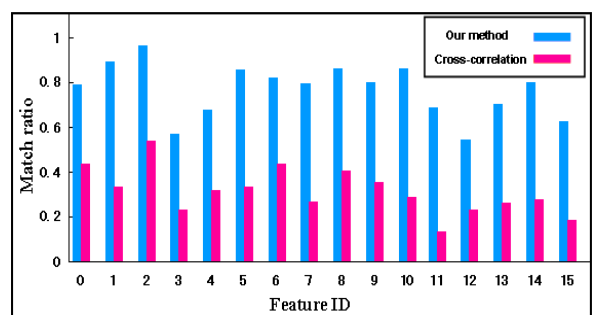
Figure 9. Feature recovering performance.